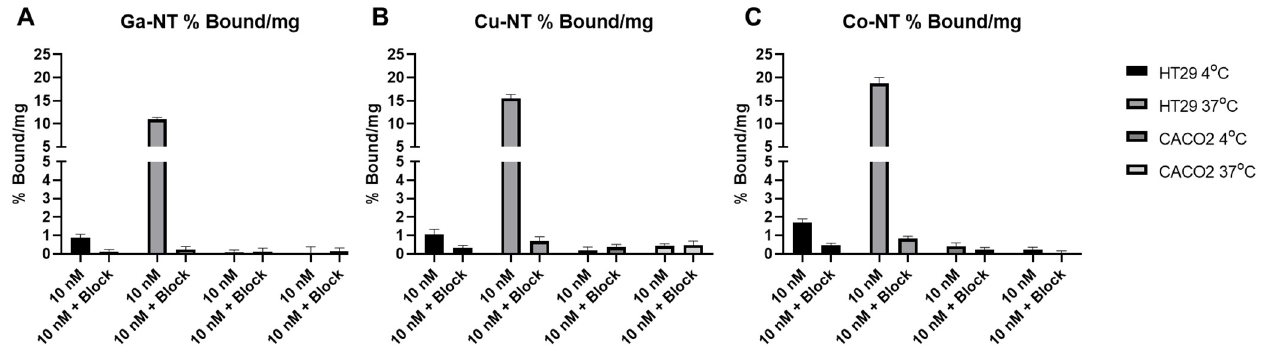
Figure 1. Cell uptake of NOTA-NT-20.3 labeled with gallium-68, copper-64, and cobalt-55 shows specific uptake in neurotensin expressing HT29 cells and minimal uptake in low neurotensin ex- pressing Caco2 cells. Cell uptake was investigated using [ 68 Ga] Ga-NOTA-NT-20.3 ( A ), [ 64 Cu] Cu- NOTA-NT-20.3 ( B ), and [ 55 Co] Co-NOTA-NT-20.3 ( C